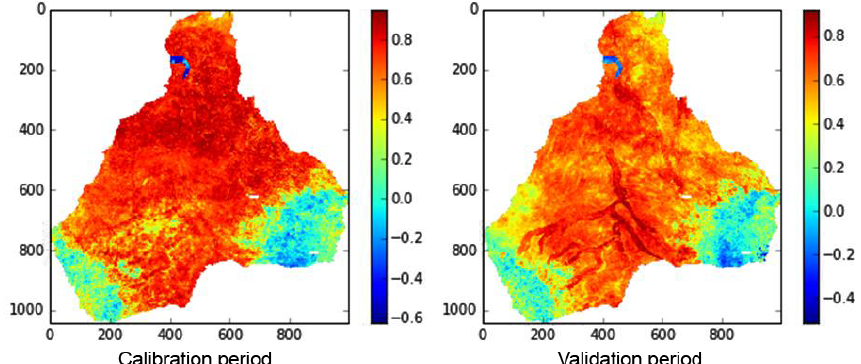
Figure 4. Temporal Pearson correlation coefficient between the NDVI provided by MODIS and the LAI simulated by the model during the calibration and validation periods. The two areas with negative values correspond to the Mount Kenya and Aberdare